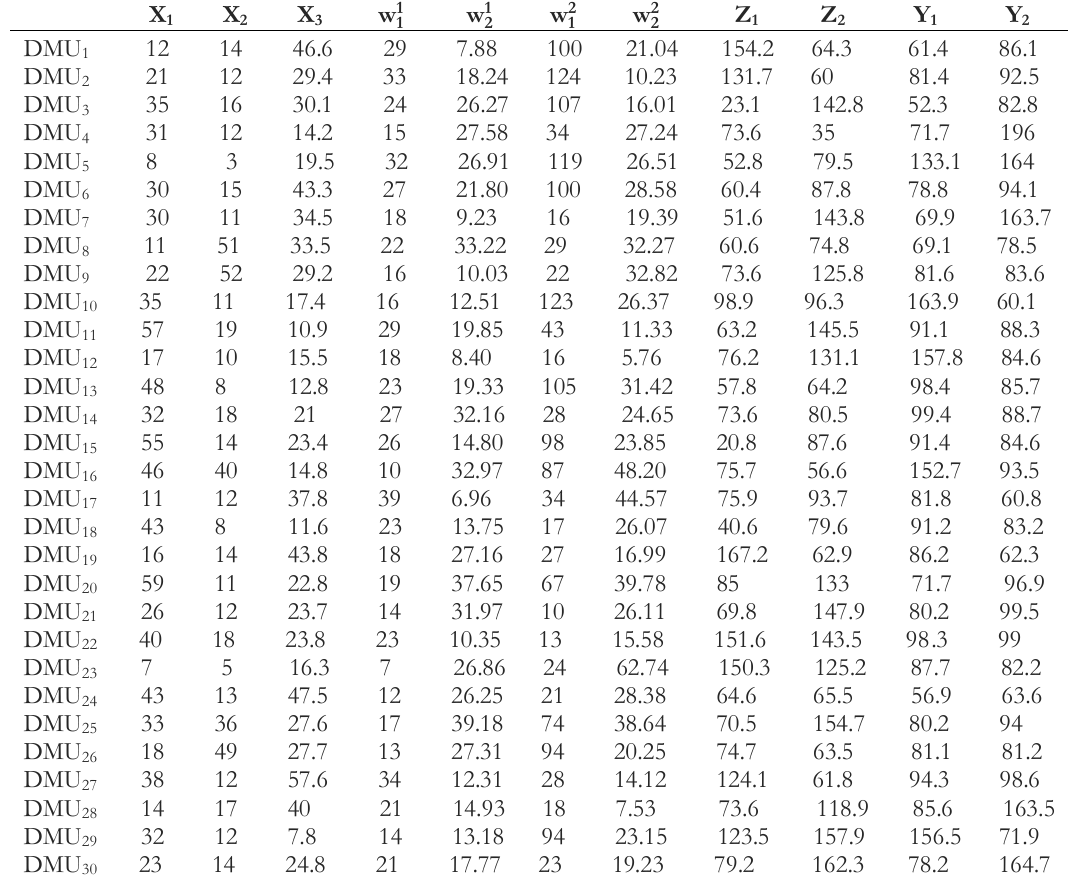
Table 1. Data in basic two-stage network with flexible